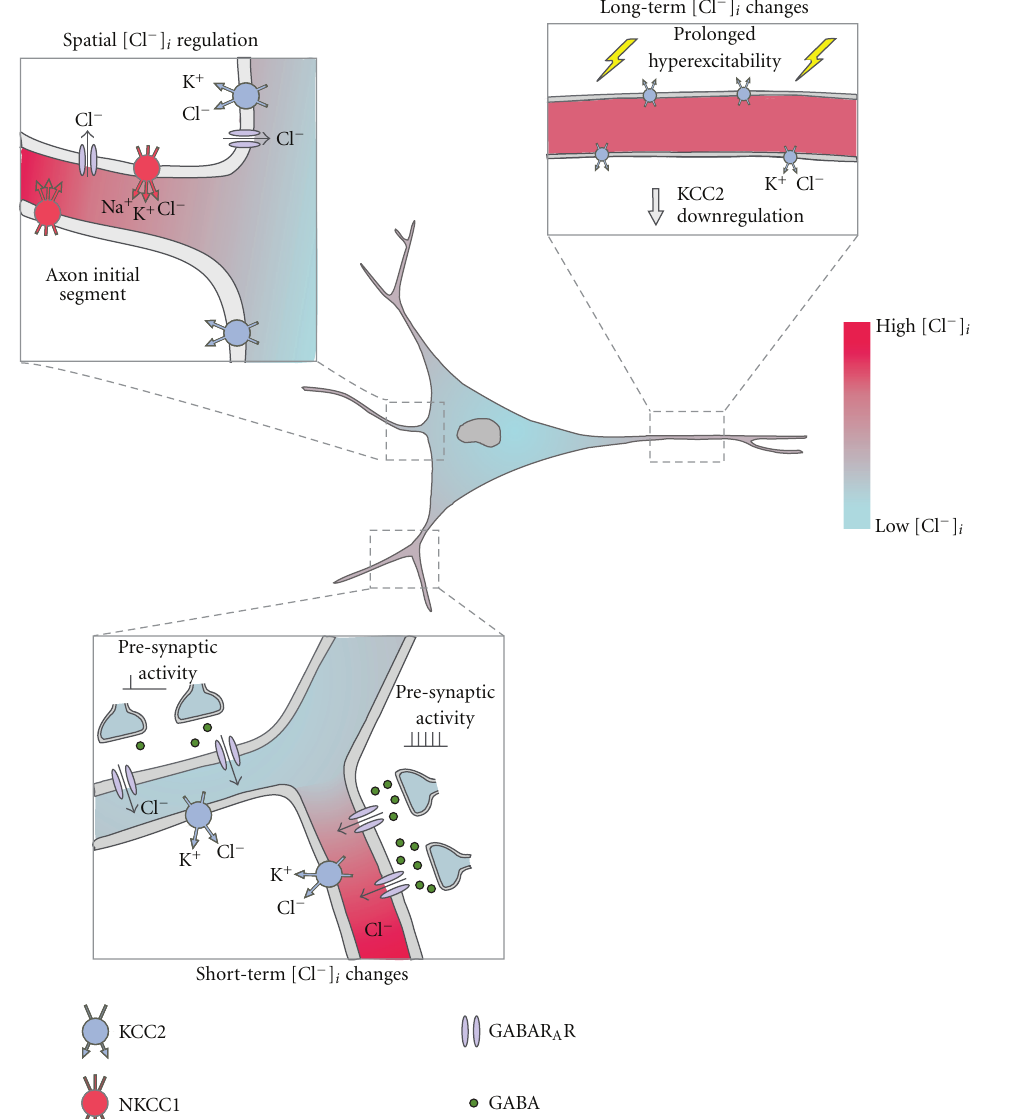
Figure 1: [Cl − ] i and the associated driving force for GABA A Rs can be subject to spatial and activity-dependent temporal variations. The upper left panel shows an example of spatially regulated [Cl − ] i . It has been reported that low levels of KCC2 expression within the axon initial segment enable NKCC1 to maintain relatively high levels of [Cl − ] i compared to the soma (indicated by the red colour inside the cell) [22–24]. This can generate a depolarising Cl − driving force for GABA A Rs within the axon [21–23]. The lower left panel shows an example of short-term [Cl − ] i loading within dendritic branches. Cl − influx associated with low-level GABA A R activity is dealt with by Cl − regulation mechanisms (left-hand dendritic branch). However, during periods of intense GABA A R activation, if E Cl − is hyperpolarised with respect to the membrane potential, high levels of Cl − influx via GABA A Rs can lead to localised increases in [Cl − ] i and consequently depolarising shifts in E GABA (right-hand dendritic branch) [25, 26]. The upper right panel illustrates an example of long-term [Cl − ] i changes. Certain patterns of neural activity within mature neurons (e.g., repetitive coincidental pre- and postsynaptic spiking or prolonged postsynaptic spiking, interictal-like activity) can lead to a downregulation in KCC2 activity, resulting in long-term increases in [Cl − ] i [10, 27,